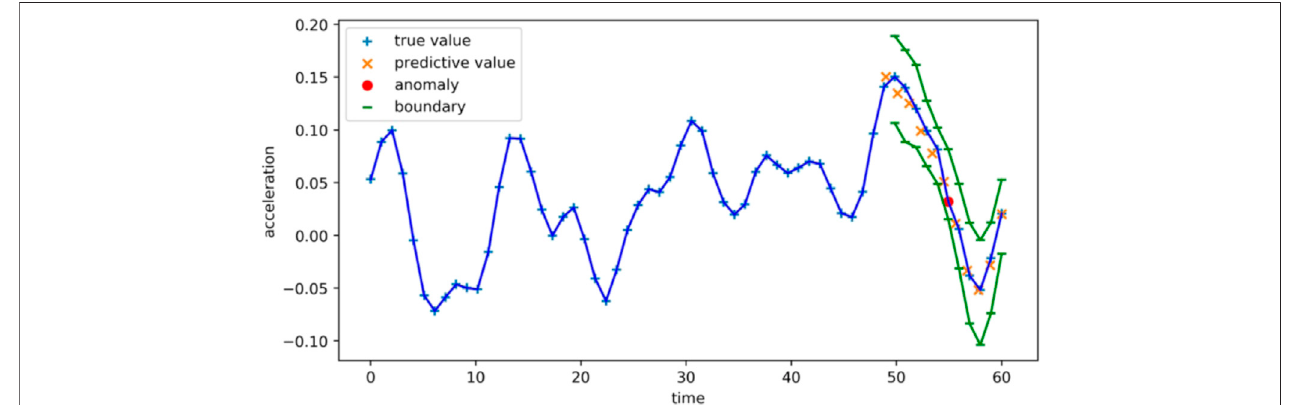
FIGURE 9 | QRNN for anomaly detection.